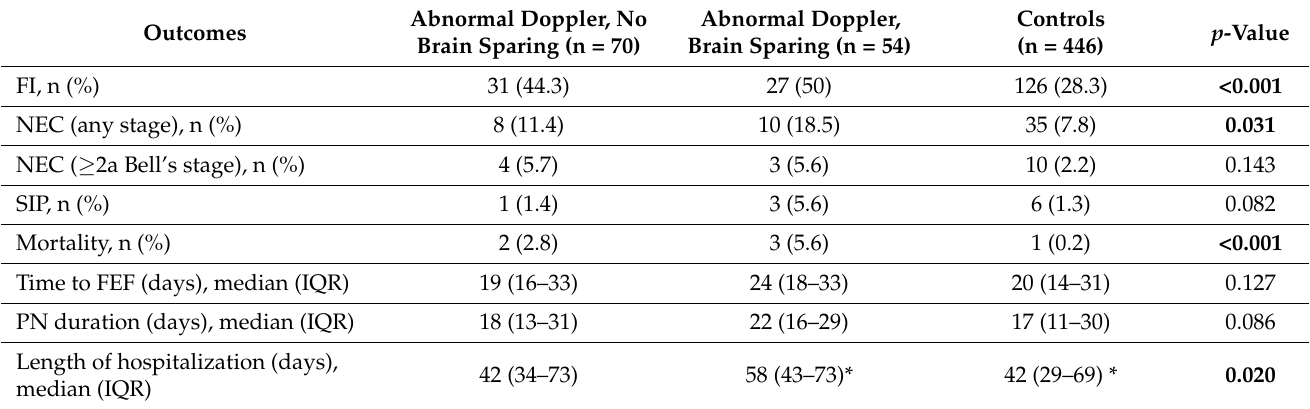
Table 5. Gastrointestinal and nutritional outcomes in infants with abnormal antenatal Doppler with and without brain sparing and controls. Significant between-group comparisons are highlighted in bold. Abbreviations: FI: feeding intolerance; FEF: full enteral feeding; IQR: interquartile range; NEC: necrotizing enterocolitis; PN: parenteral nutrition; SIP: spontaneous intestinal perforation.